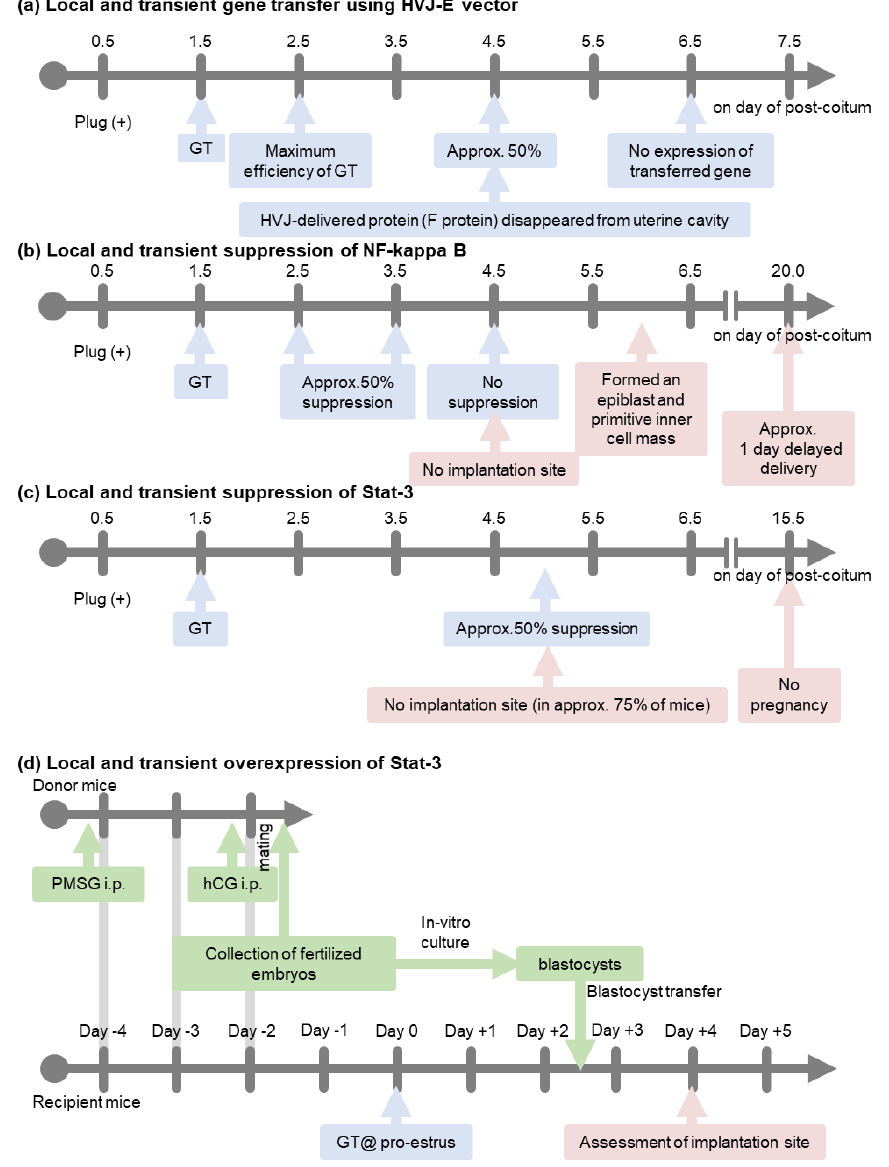
Figure 2. Time course of gene transfection. GT: gene transfer, PMSG: pregnant mare serum gonadotropin, hCG: human chorionic gonadotropin.